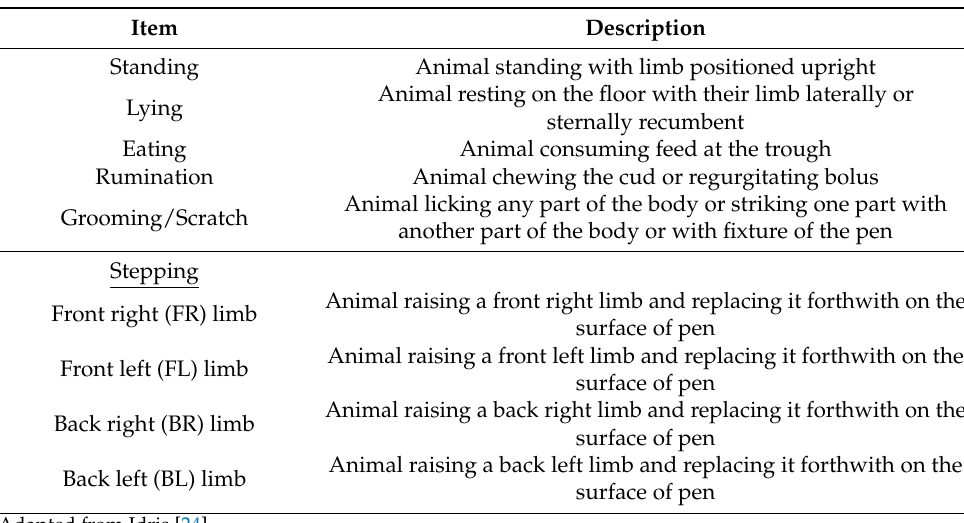
Table 3. Ethogram for recorded behaviours for cattle housed in individual pens in the climate- controlled